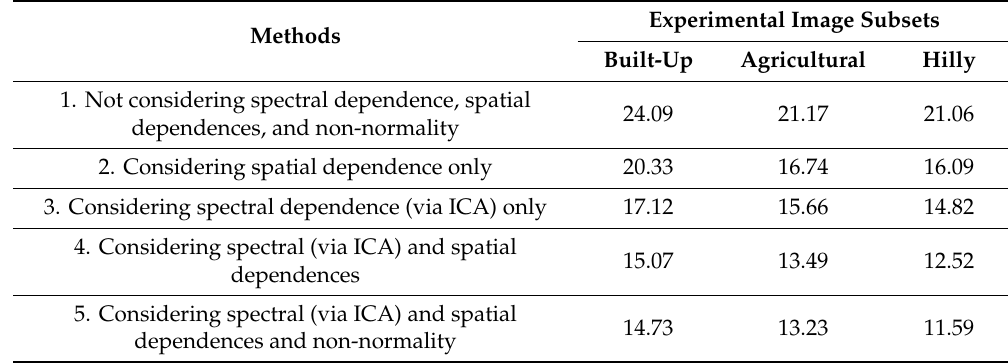
Table 7. Estimates of information content for the three TM image subsets using di ff erent methods labeled as in Table 6 (bits /